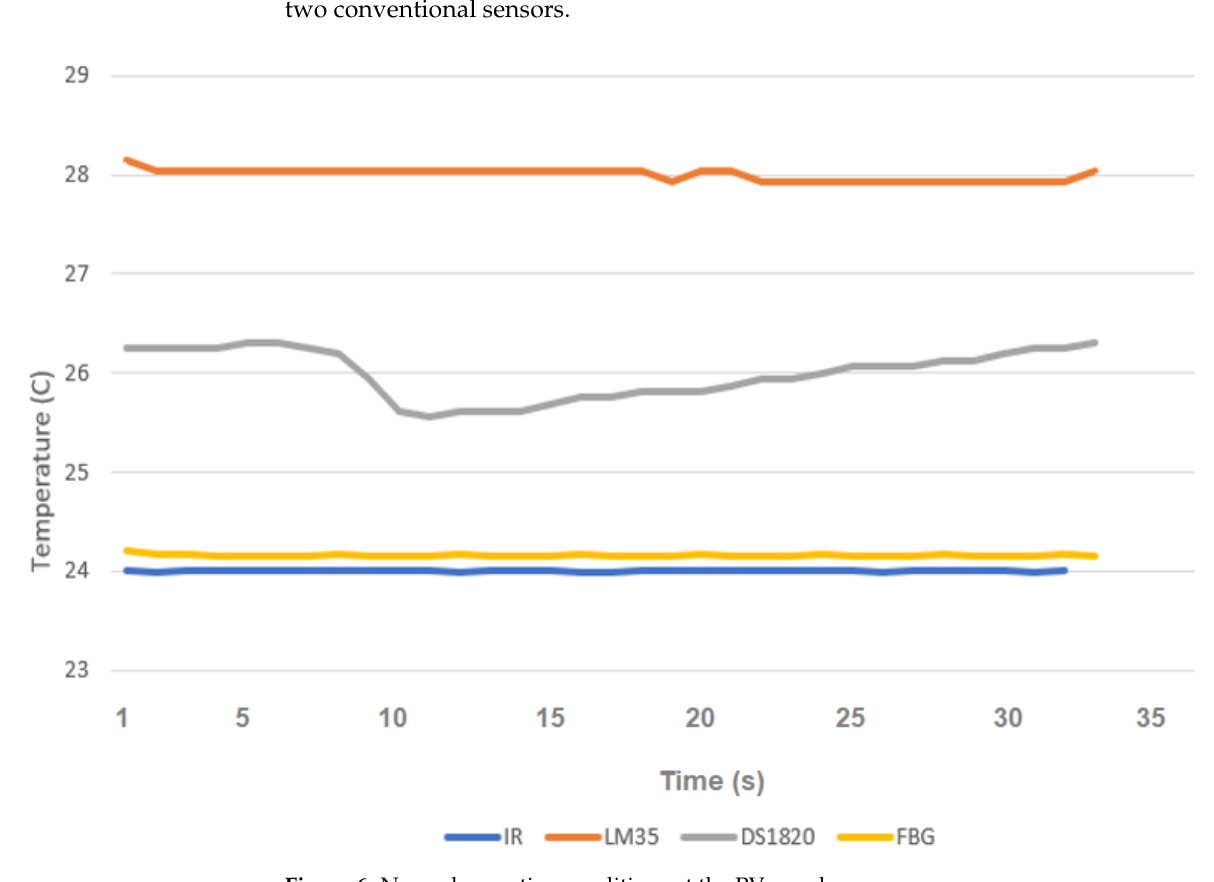
Figure 6. Normal operating conditions at the PV panel.